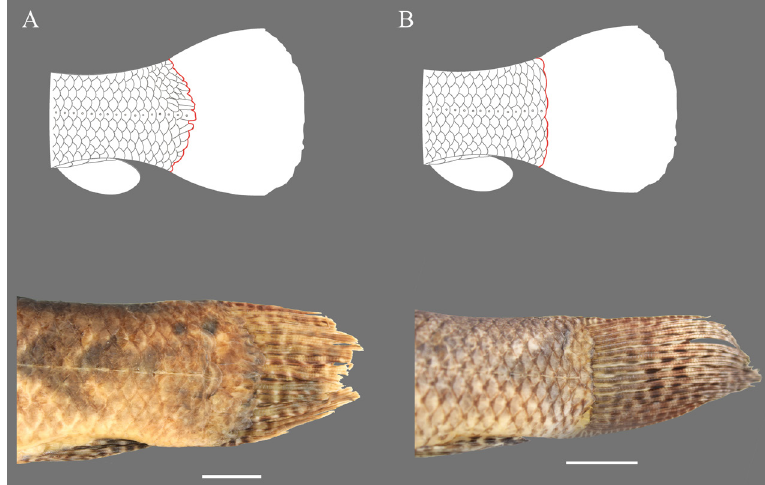
FIGURE 3 | Last vertical series of scales on the base of the caudal-fin rays. Comparison between Hoplias misionera ( A ), UFOPA AMTRA131-19, 237 mm SL and Hoplias cf. malabaricus ( B ), UFOPA AMTRA110, 201 mm SL. Scale bars = 1 cm. Photos by L. R. R. Rodrigues. Illustration by T. M. A.